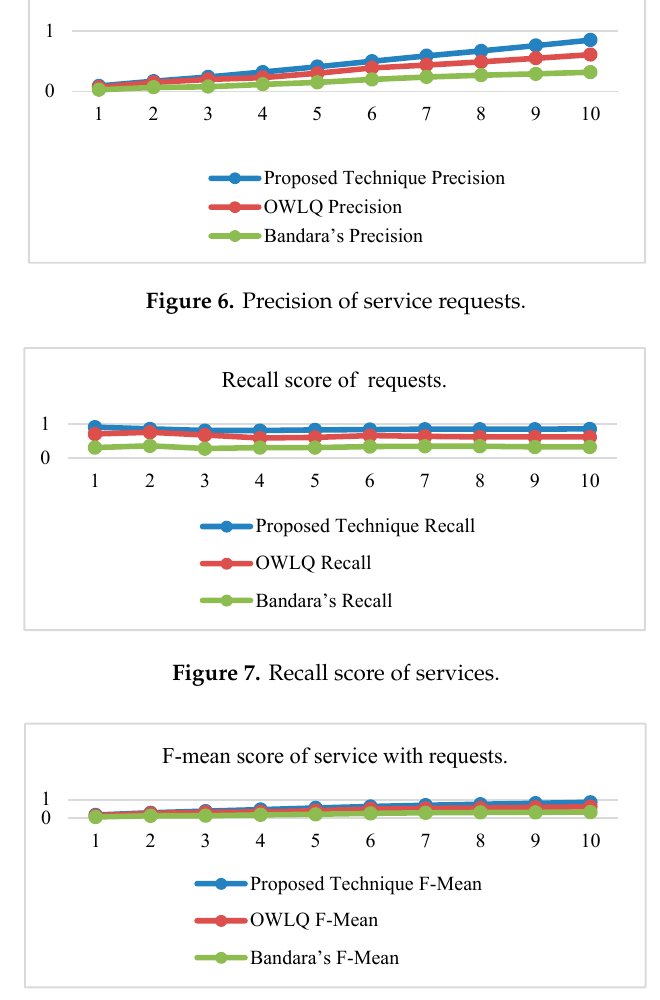
Figure 8. F-mean score of services.